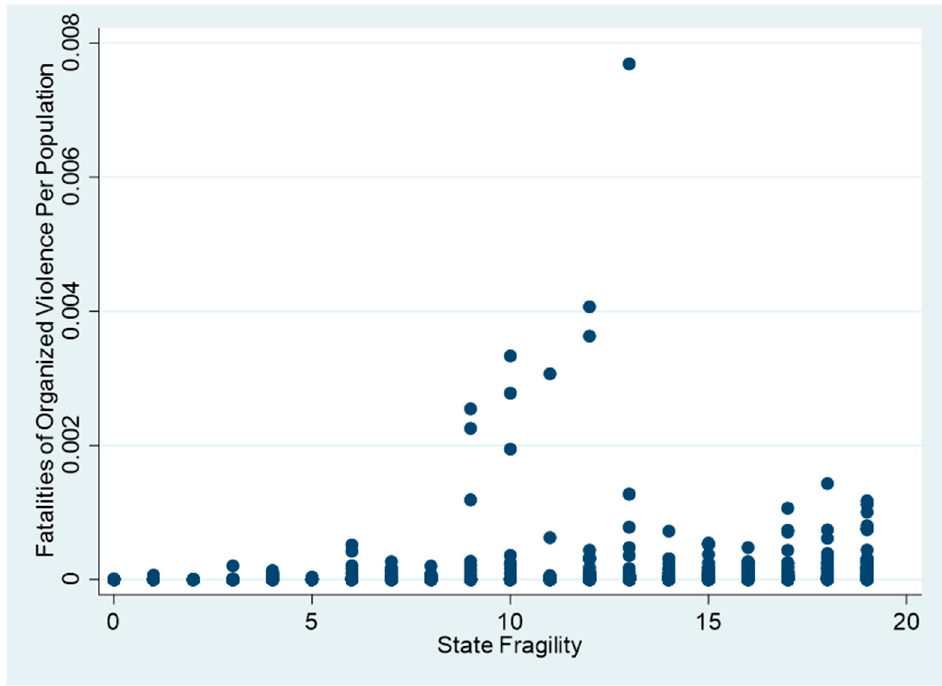
Figure 1. State Fragility and Fatalities of Organized Violence Per Population World Data.